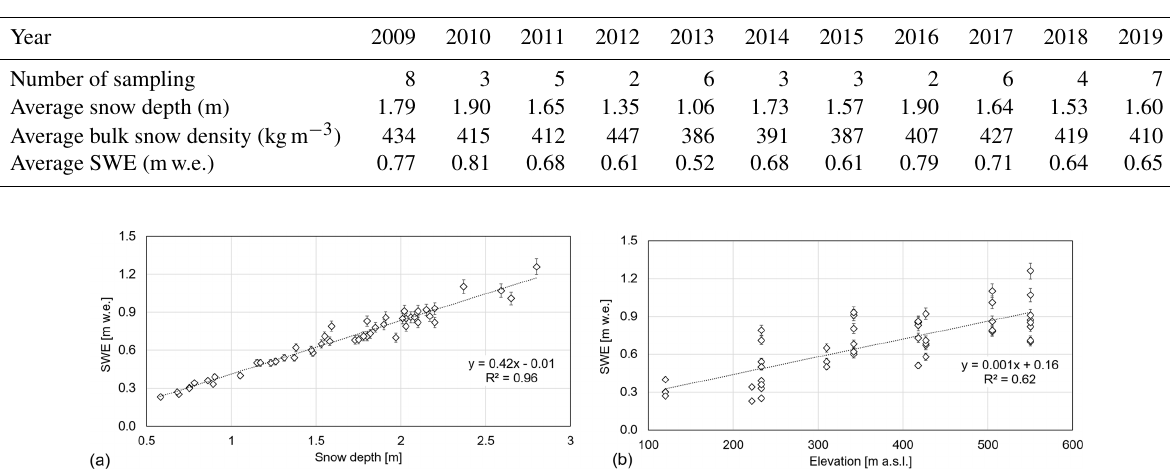
Figure 5. Relationship between SWE and snow depth (a) and SWE and elevation (ma.s.l.) (b) . Whiskers show an error (total differential function; Eq. 4).